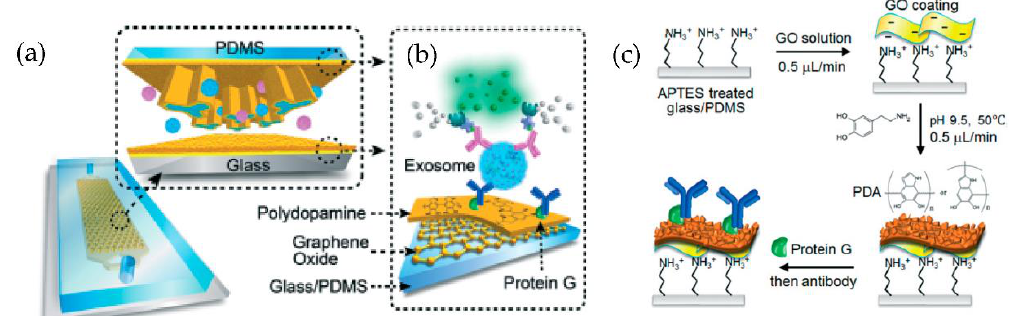
Figure 13. The setup and workflow of the ExoSearch chip for continuous mixing, isolation, and in situ, multiplexed detection of circulating exosomes. (Reproduced from Zhao Z. et al. [78]. Copyright 2016, Lab Chip).